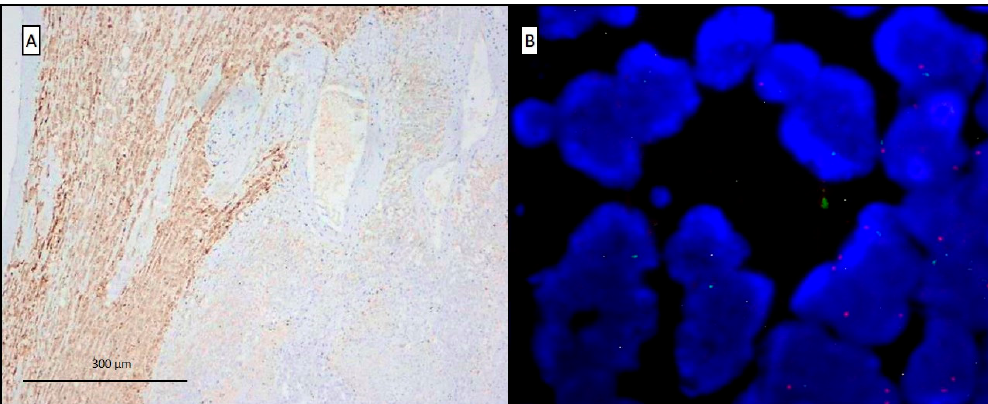
Figure 3. In the liver, Hep Par-1 (OCH1E5) was negative, marking only the hepatocytes and some necrotic debris ( A , scale bar: 300 µm), and fluorescent in-situ hybridization (FISH) was performed for the CDKN2A /p16 gene, revealing the homozygous deletion (more than 50%) ( B ). The same results were obtained with examination of the pleural mass.